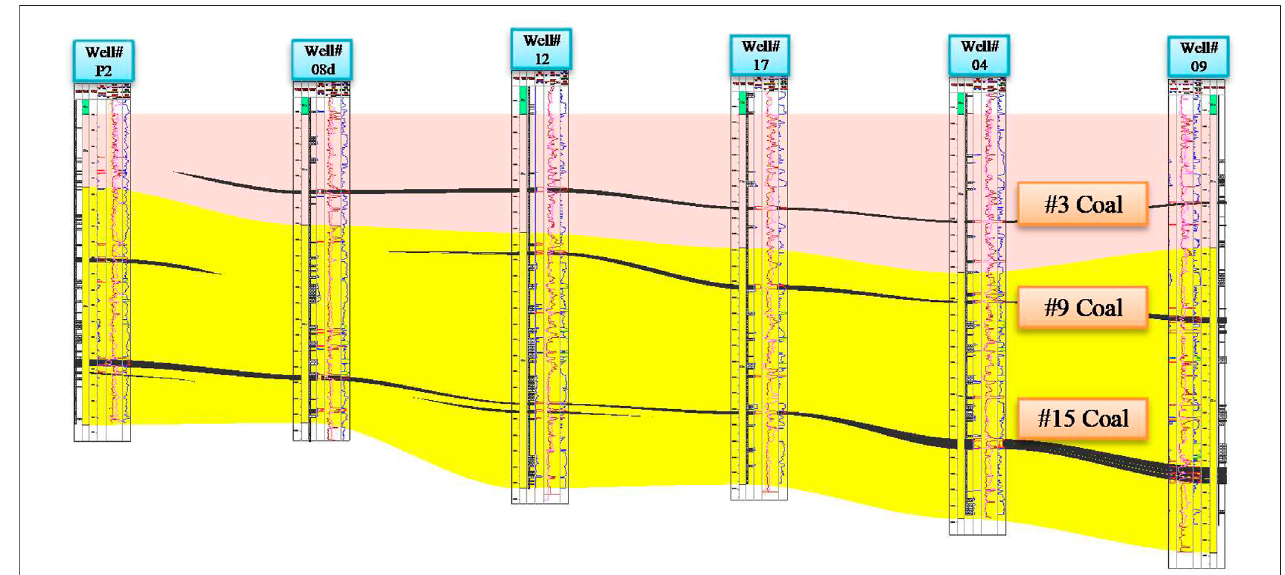
FIGURE 1 | Distribution of coal seam reservoirs in Block